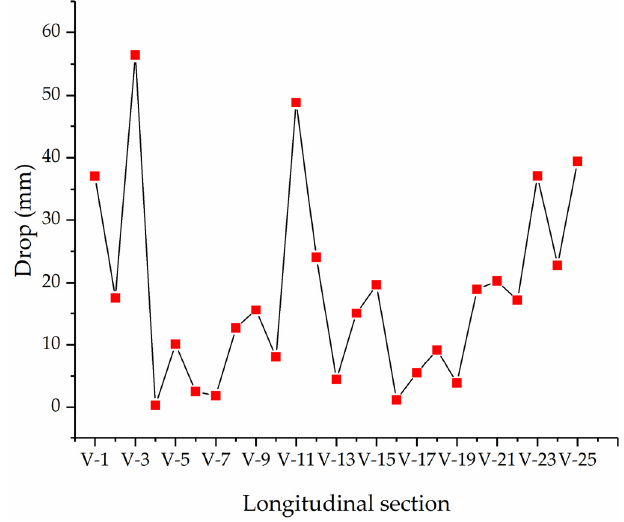
Figure 17. The ground fissure drop in each longitudinal section.